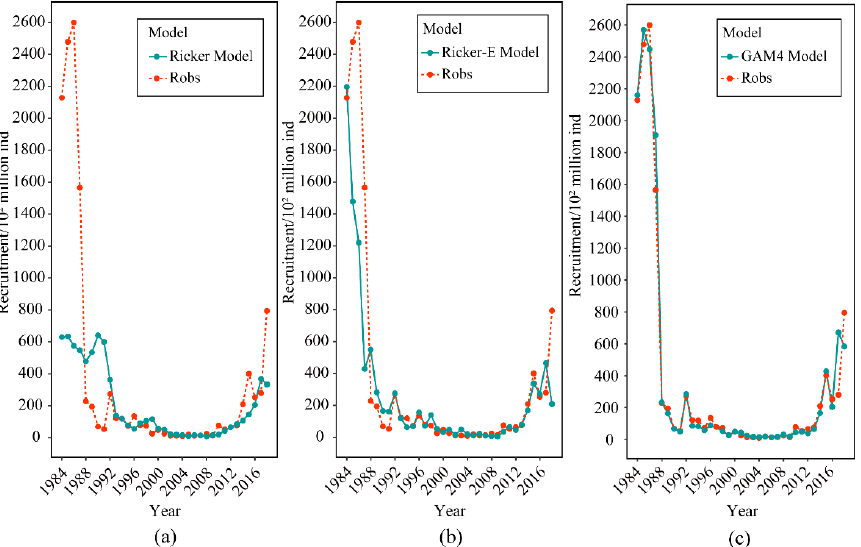
Figure 9. Comparing the optimal model predicted value to the observed value fit. The Robs represents the observed value of the recruitment (red line), and the ( a ) Ricker model, ( b ) Ricker-E model, and ( c ) GAM4 represent the predicted value of each optimal model (green line),